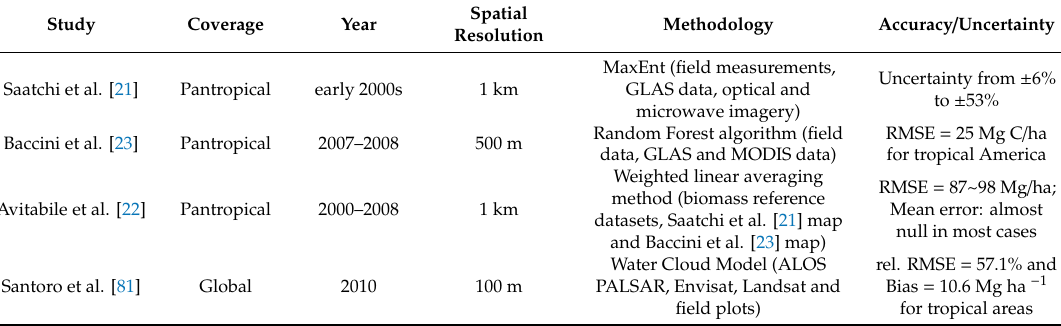
Table 2. Summary of forest aboveground biomass (AGB) maps used for comparison with our